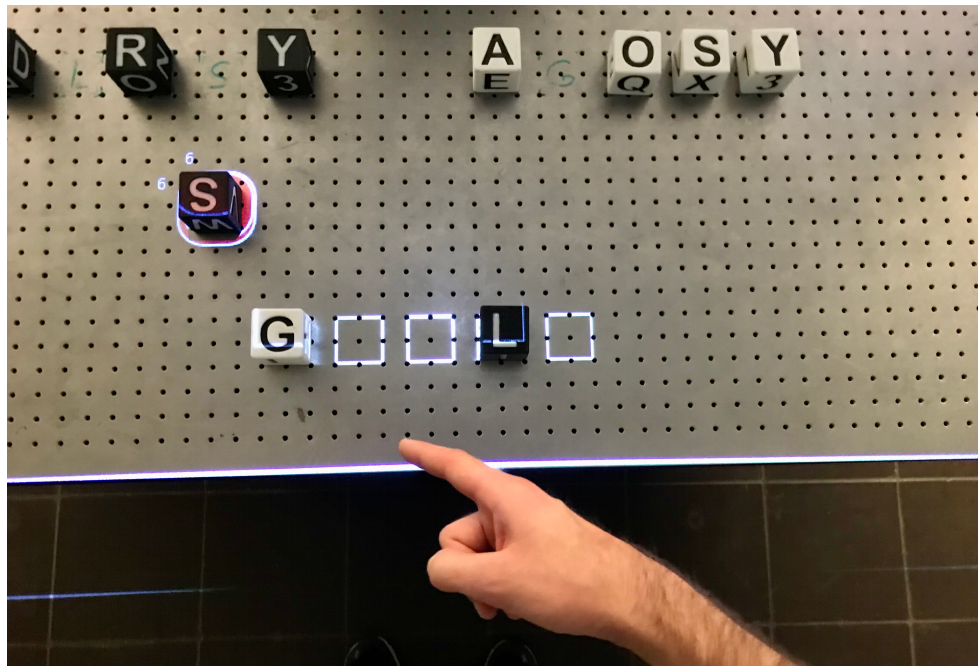
Figure 14. Pointing gesture: User points to cube [S], which is enveloped by the laser pointer.